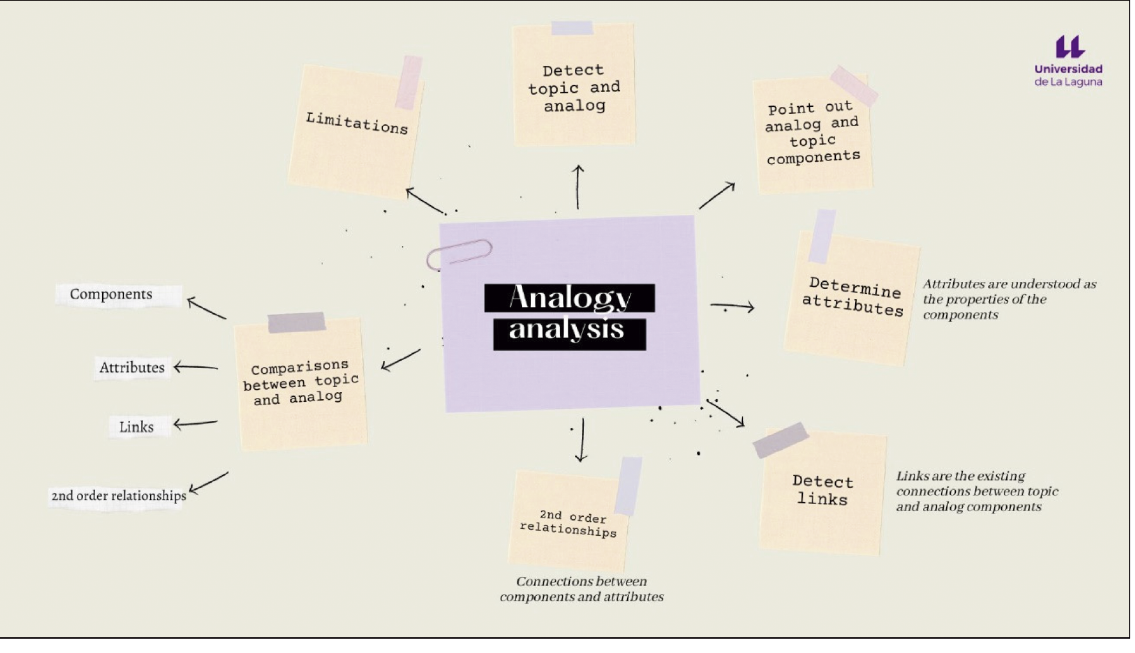
Figure 4. Analogy analysis